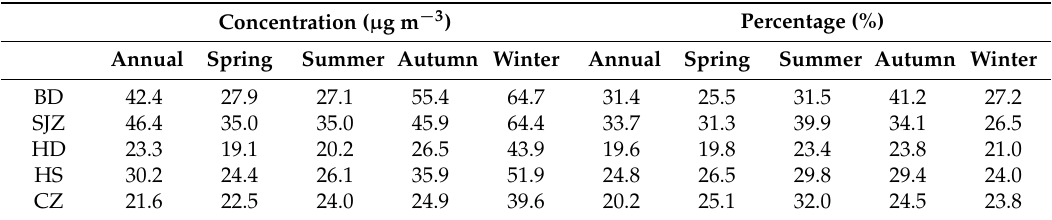
Table 3. Annual and seasonal transported PM 2.5 concentrations and contribution percentages in 5 cities during 2013–2015.